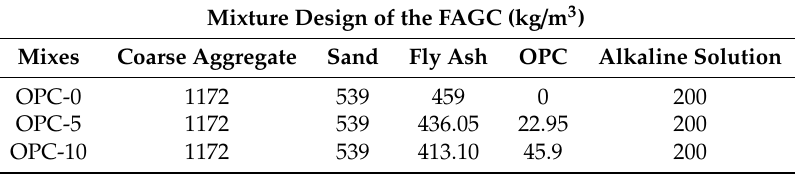
Table 3. Mixture design of the FAGC.